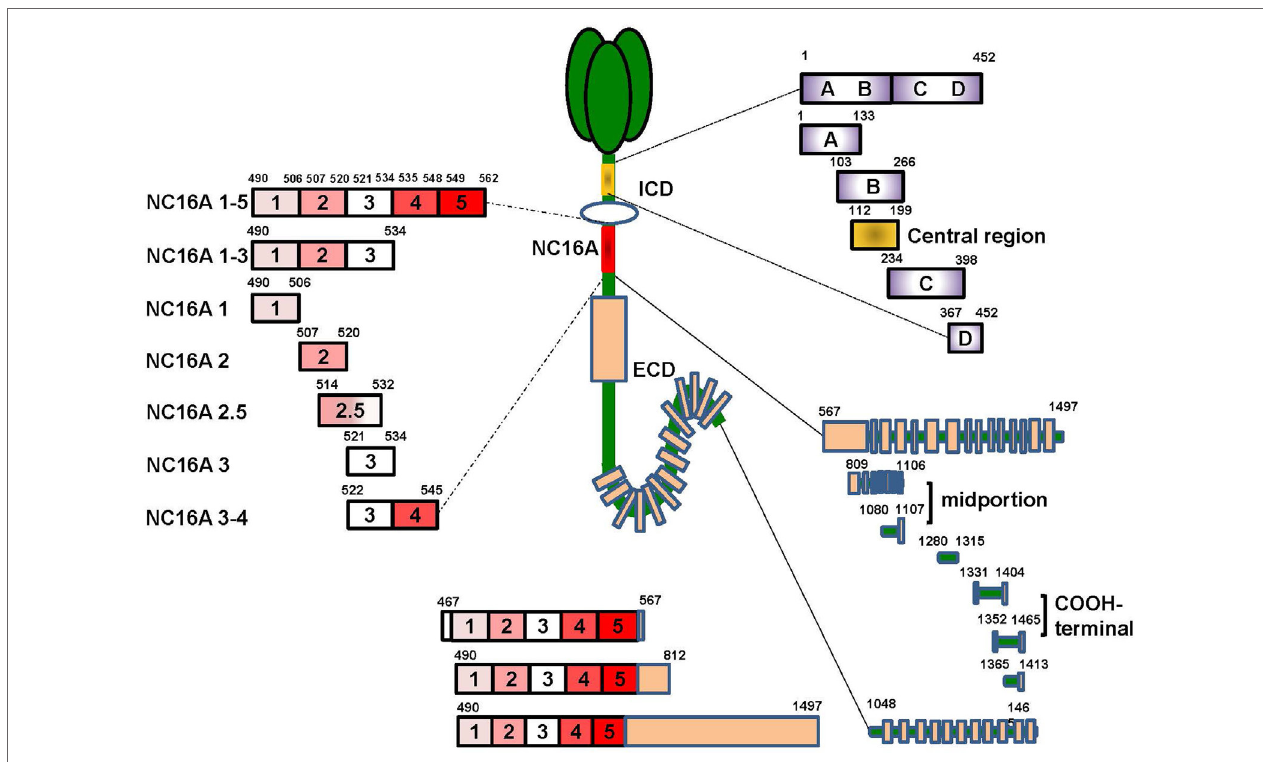
FigURe 1 | The target sites of the BP180 molecule. BP180 is a multi-epitope protein with three major domains-the intracellular domain (ICD), the NC16A domain and the ectodomain outside NC16A domain. The ICD include five target sites, including aa 1–452, aa 1–133, aa 103–266, aa 234–398, aa 36–452 and a central region aa 112–199. The NC6A domain contain seven targeted sites, that is, NC16A1-5, 1-3, 1, 2, 2.5, 3, 3-4. The ectodomain domain also have eight functional sites, namely aa 567–1497, aa 809–1106, aa 1080–1107, aa 1280–1315, aa 1331–1404, aa 1352–1465, aa 1365–1413, and aa 1048–1465. Additionally, there are also target sites crossing more than one domain, such as aa 46–567, aa 490–812, and aa